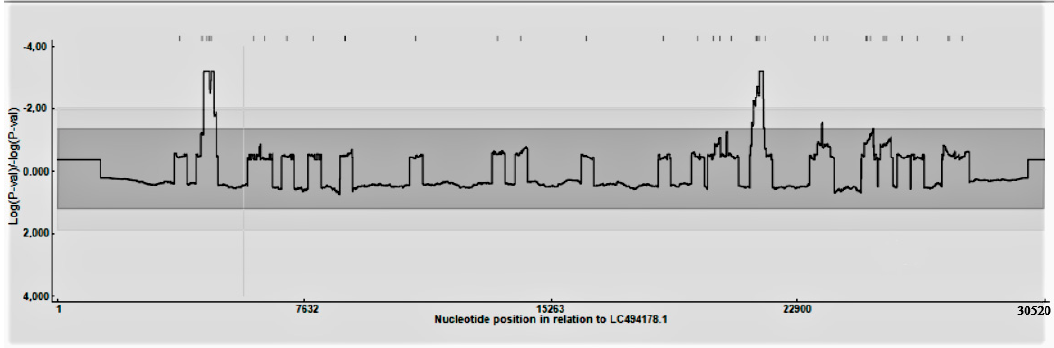
Figure 1. Recombination distribution plot. The significance ( p -value) of hot and cold-recombination spots is reported along the genome.